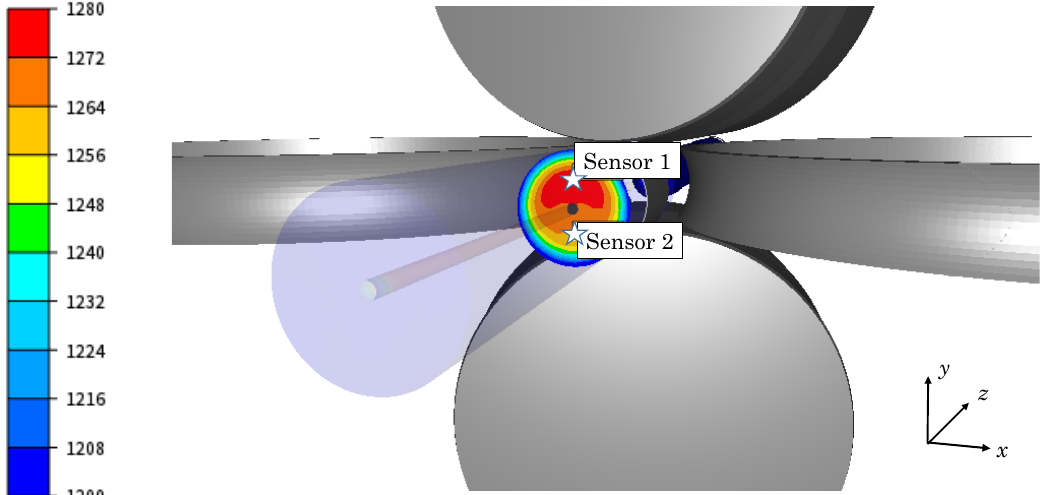
Figure 3. Position of the sensors 1 and 2 in the cross-section of the